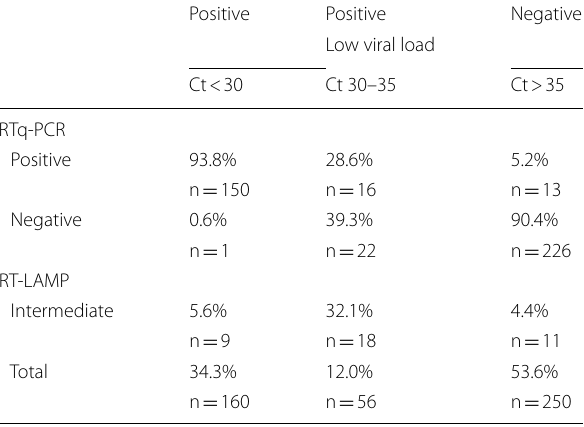
Table 2 RT-LAMP results testing 466 clinical samples stratified